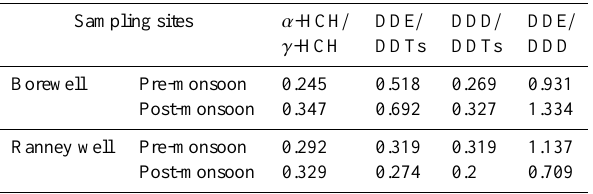
Table 9. Concentration ratios of selected OCP’s compounds in the ground water according to the sampling source and